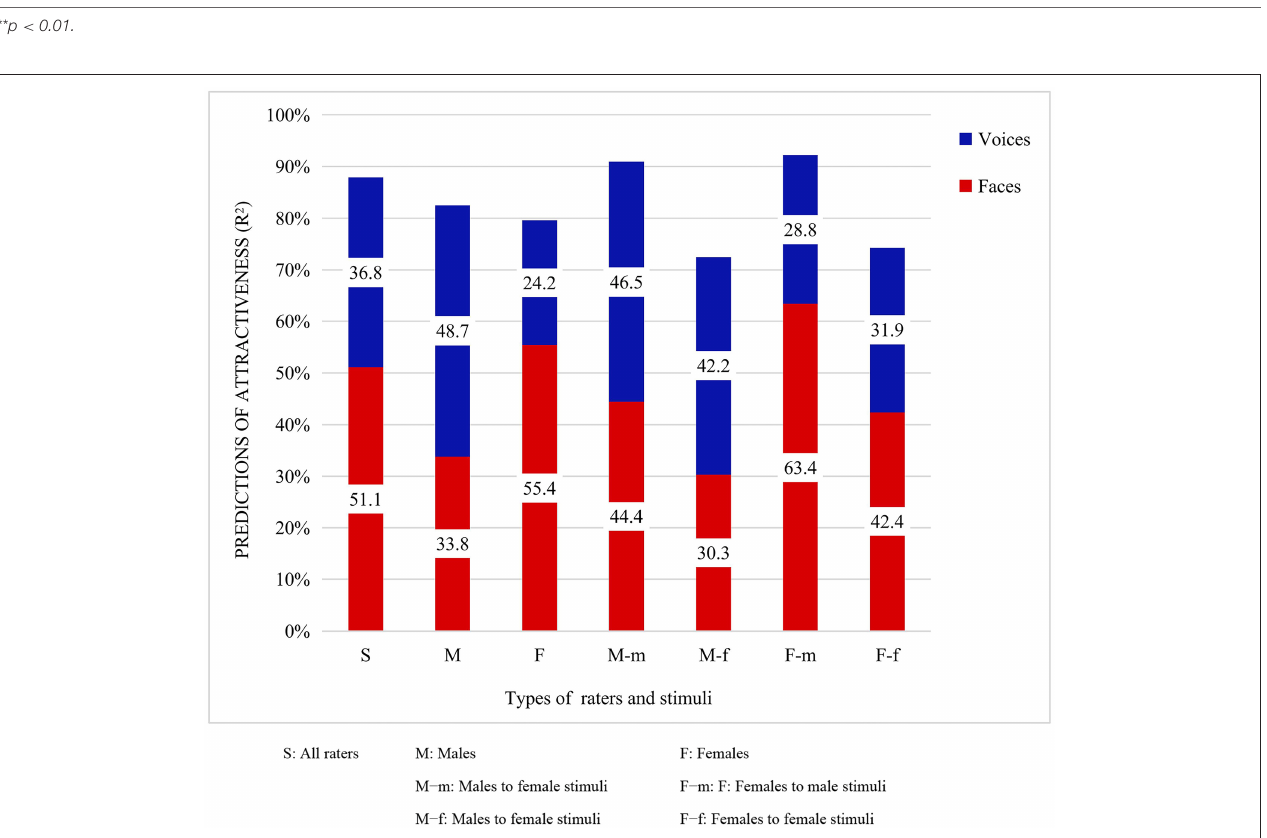
FIGURE 5 | Regression analysis of predictions (predicted power R 2 ) of FA and VA in multimodal stimuli in Study 2.